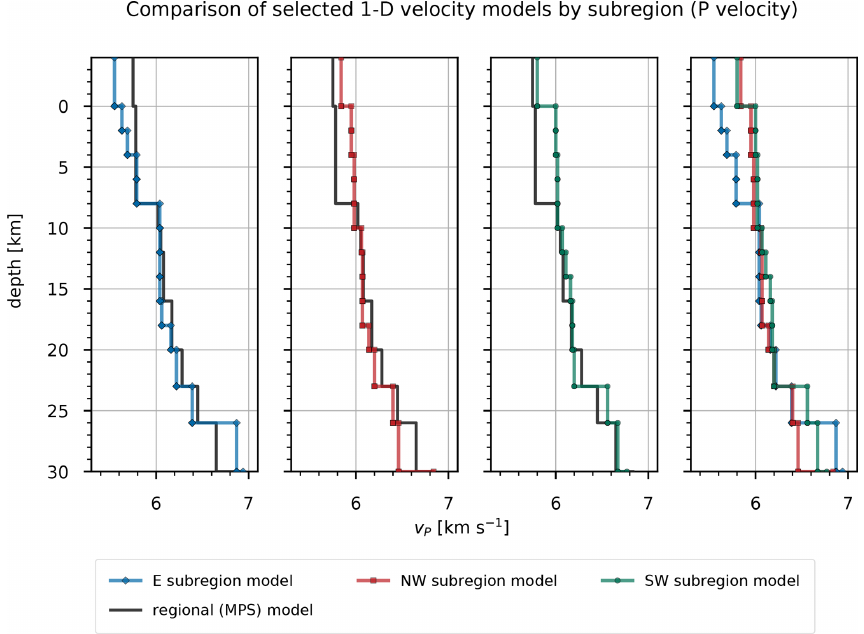
Figure 13. P velocities computed for a particular subregion. The thick black line shows P velocities of the regional (MPS) model. Corre- sponding values are given in Tables S4, S5, and